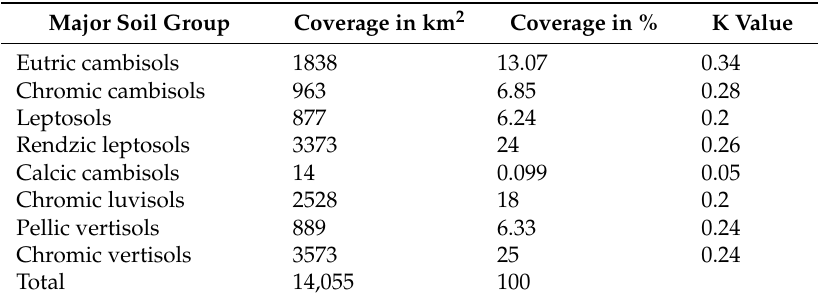
Table 2. Soil group and K-factor values of Welmel watershed.